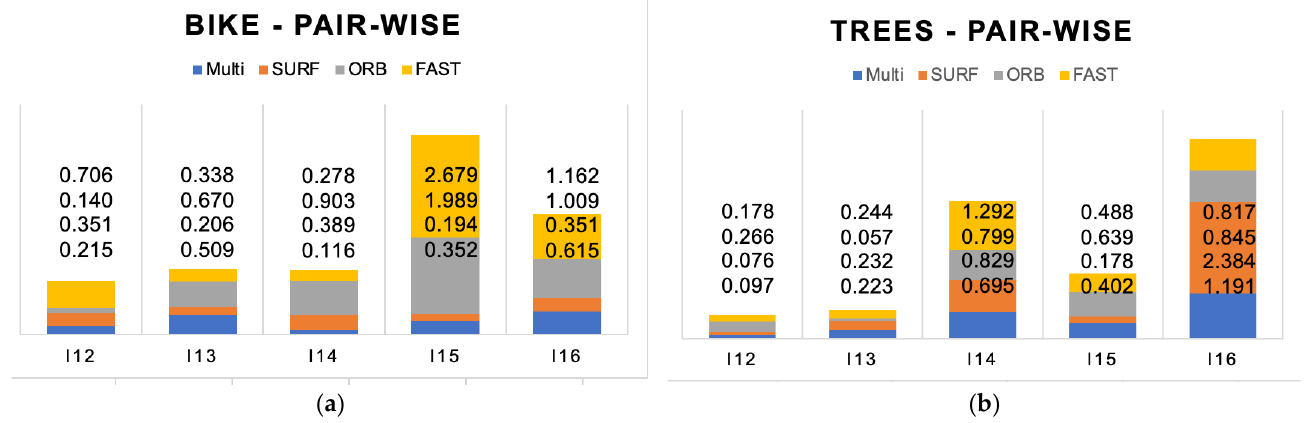
Figure 8. Pairwise RMSE [m] evaluation of H-matrix estimation of bike ( a ) and trees ( b ).